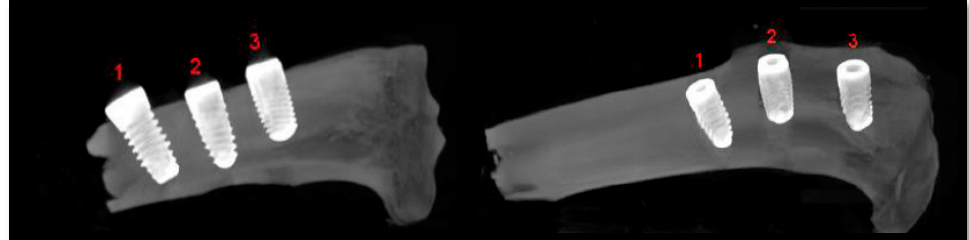
Figure 17. Computerized microtomography of two of the tibias analyzed, in which the different types of implants used in the study are observed [ 1 . HA/TCP (BioHorizons); 2. SLA (Ziacom); 3. HA + AW (Zimmer)].